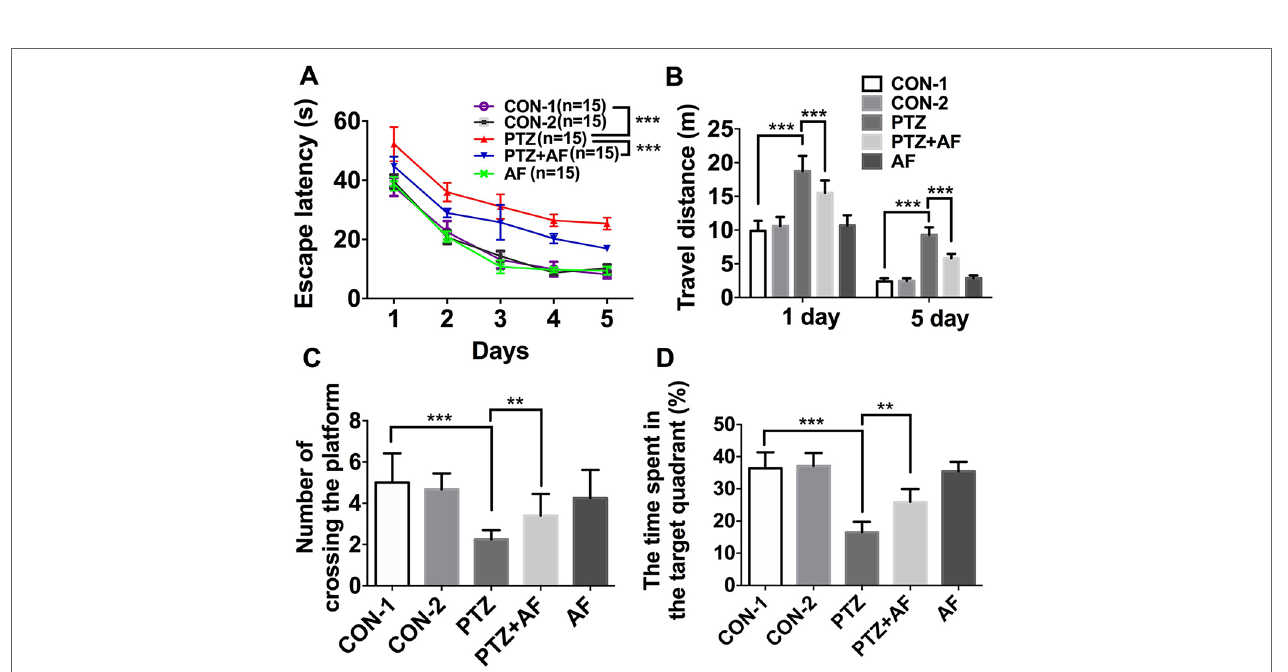
FIGURE 2 | Effects of amentoflavone on cognitive deficits induced by PTZ kindling. (A) Statistical results showing the decrease in escape latency by amentoflavone (two-way ANOVA with repeated measures followed by Bonferroni or Dunnett’s T3 post hoc test ). (B) Statistical results showing the decrease in swimming distance by rats in search of the hidden platforms due to amentoflavone treatment ( Student’s t test ). (C) Statistical results showing the increase in the number of rats crossing the target quadrant due to amentoflavone treatment ( Student’s t test ). (D) Statistical results showing the increase in the time spent in the target quadrant due to amentoflavone treatment ( Chi-square test ). Error bars represent mean ± s.d. **, *** represent p < 0. 01, p < 0.001, respectively. PTZ, pentylenetetrazole; AF,